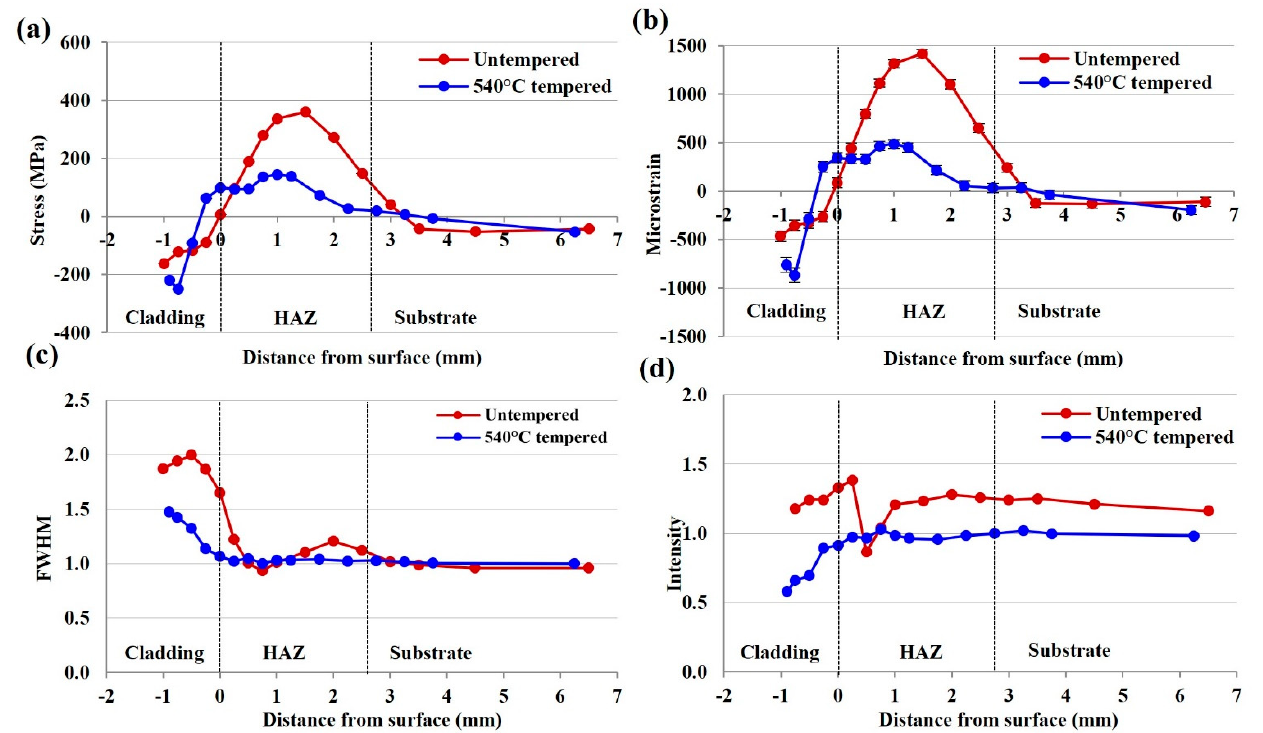
Figure 9. Longitudinal ( a ) stress, ( b ) microstrain, ( c ) FWHM, and ( d ) intensity of the untempered laser clad rail and 540 °C tempered plate.